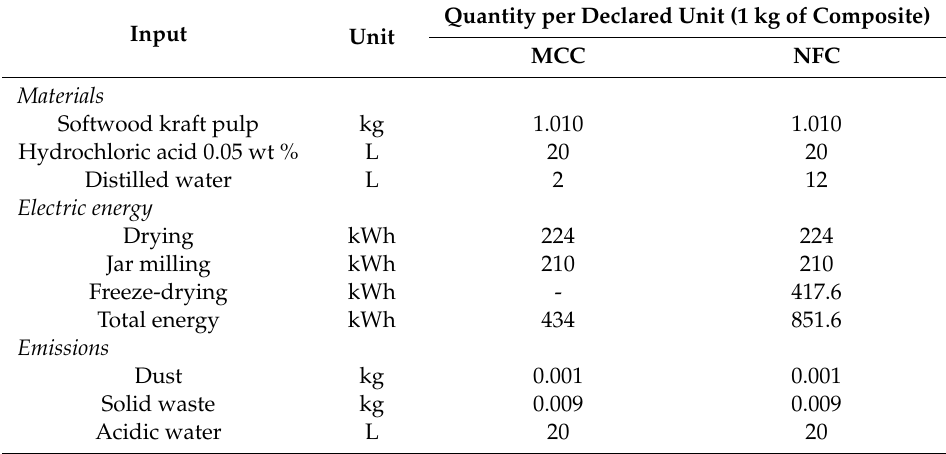
Table 2. Materials and energy flows for the laboratory manufacture of the MCC and